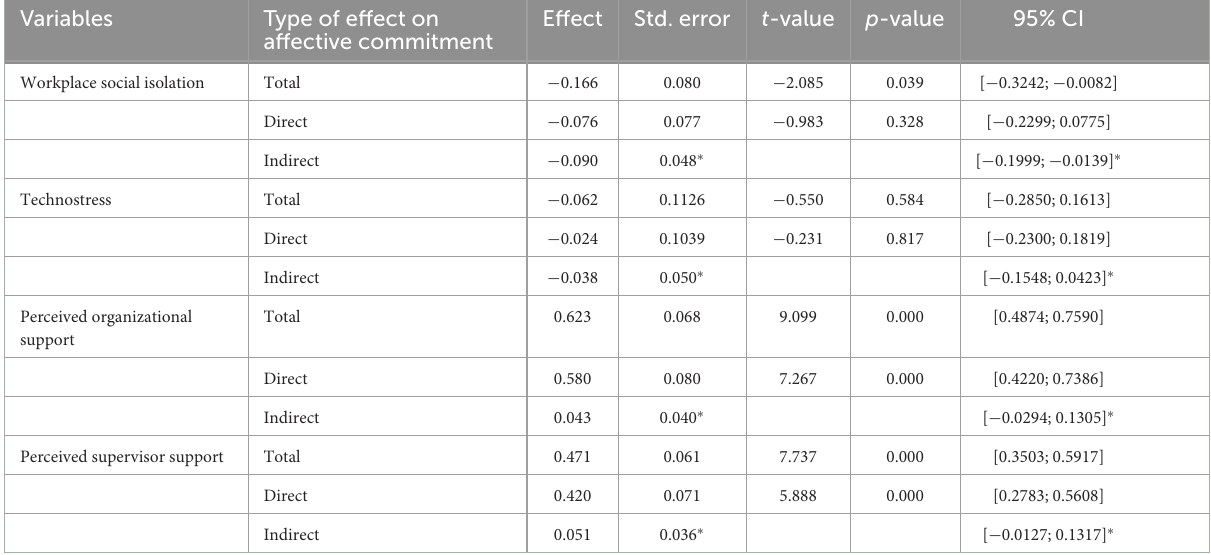
TABLE 4 Total (without mediator), direct (with mediator), and indirect (with mediator) effects. Variables Type of effect on affective